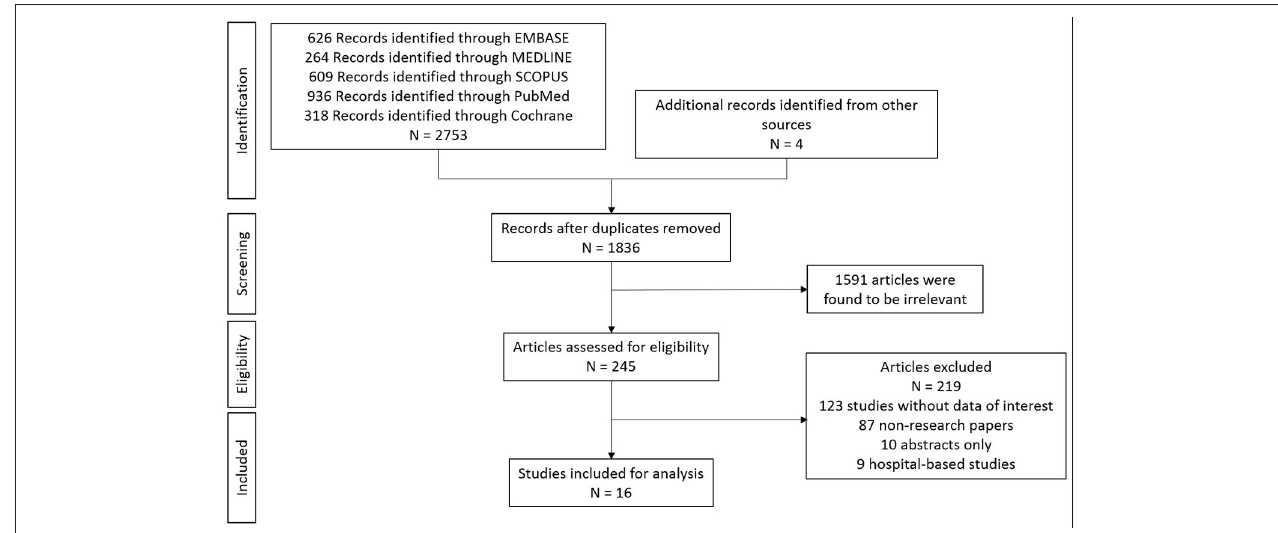
FIGURE 1 | Article selection process of systematic